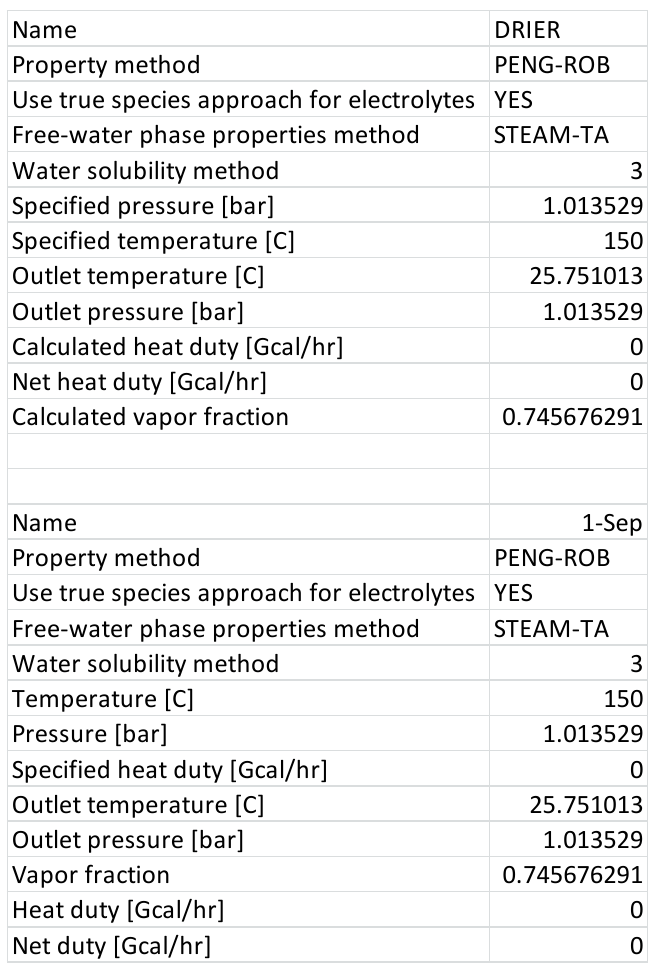
Figure A4. Pyrolysis drier and separator results.